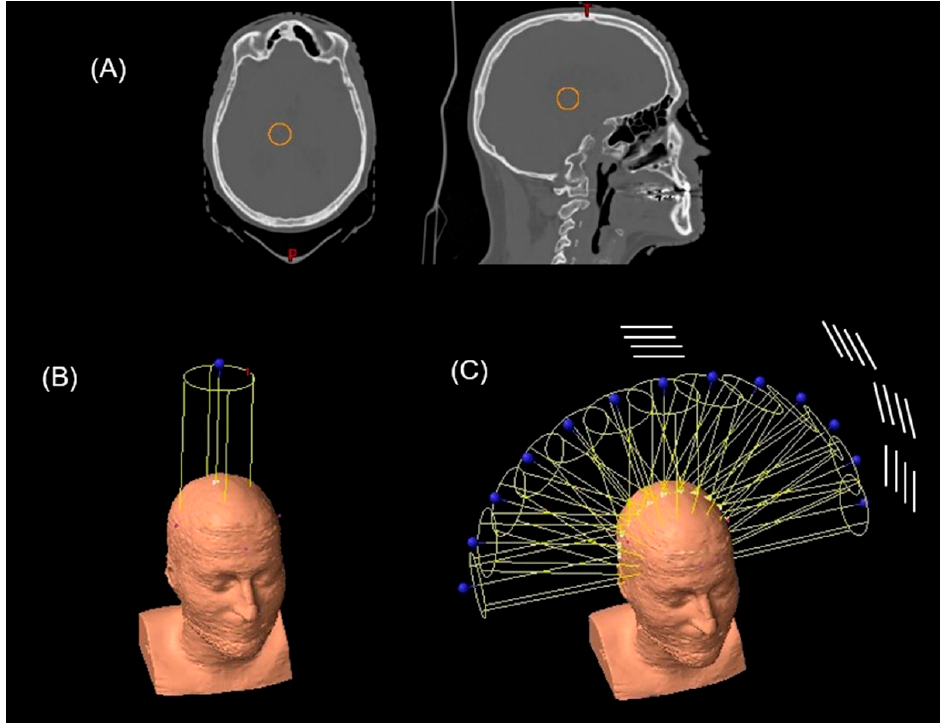
Figure 1. ( A ) PTV (orange solid line) in the axial and sagittal view of the patient CT. Beam ar- rangement in the ( B ) standard pMBRT (single array) and ( C ) PAT and pMBAT (multi-array) plans. In ( C ), a schematic sketch of the rotation of the slits is